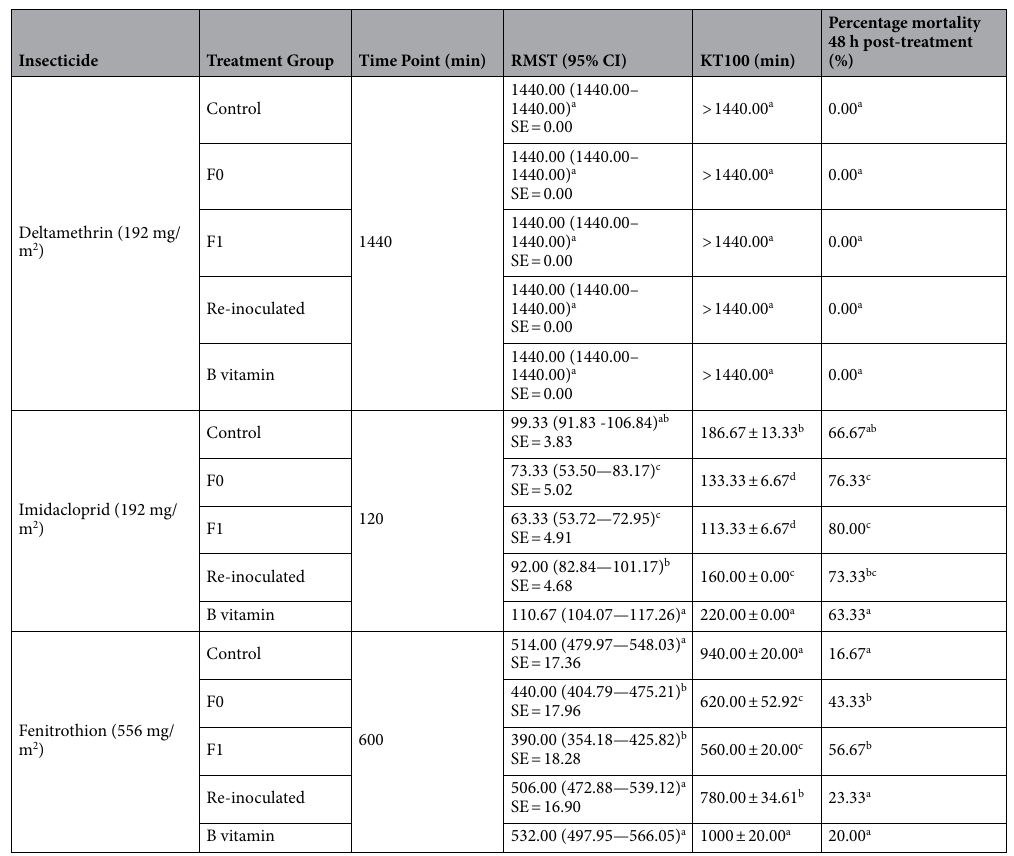
Table 1. Restricted mean survival time (RMST) and knockdown response of C. hemipterus under 24 h continuous exposure and percentage mortality 48 h post-treatment against three different classes of insecticides. Different letters in each row for each insecticide class indicate significant differences based on the comparison of restricted mean survival time (RMST) as determined by MedCalc software ( P < 0.05) after Benjamini–Hochberg correction; Duncan’s multiple range test P < 0.05 for time to knockdown 100% bed bugs (KT100) and percentage mortality reported at 48 h post-treatment. Time point for RMST is pre-specified by Medcalc statistical software, set to the lowest time point of the last event among the different